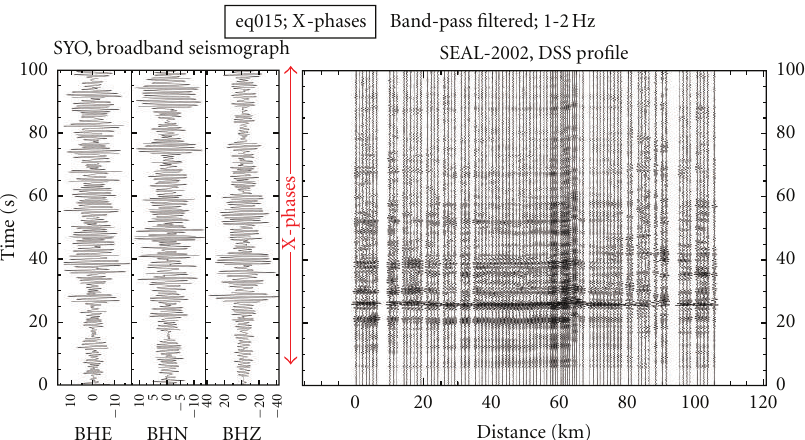
Figure 12: Record section showing the X-phases (event#; eq015) with a band-pass filter (1.0-2.0 Hz). Vertical axis starts from January 27, 2002, 14:02:30 (UTC). (left) Three-component broadband seismograms at SYO (right) SEAL-2002